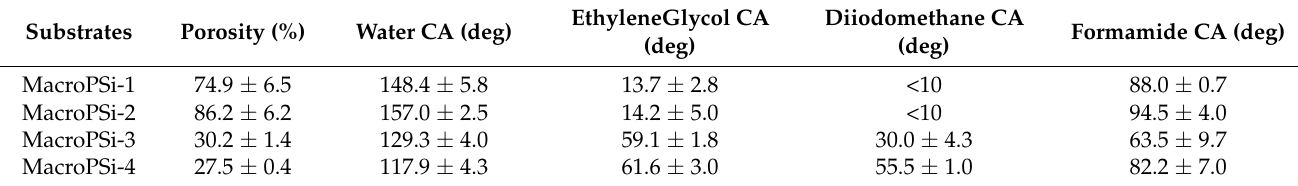
Table 4. Summary of contact angle values for MacroPSi substrates using different solvents. Substrates